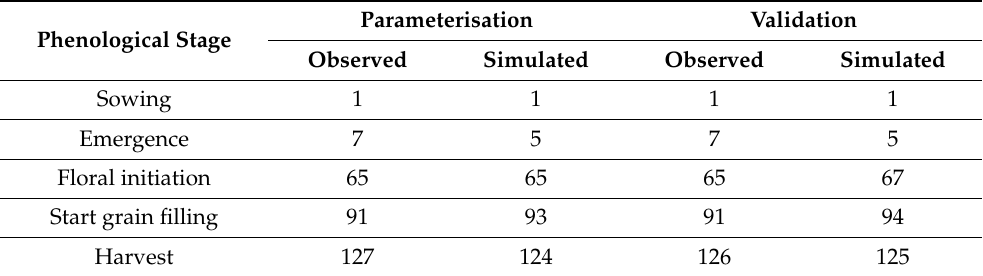
Figure 3. Photographs of the V-notch (90 ◦ ) and irrigation canals used to conduct this study. The observed and simulated phenology for the parameterisation and validation data- sets are shown in Table 2 (parameterisation and validation were conducted using 2018–2019 and 2019–2020 data, respectively). The minimum (mean minus standard deviation) and maximum (mean plus standard deviation) standard deviation ranges for the harvest days, based on three field plots, were 124 and 130 days after sowing for the parameterisation dataset, respectively. The simulated harvest days after sowing for the parameterisation period was within the standard deviation of the observed mean, indicating adequacy of the parameterisation. The minimum (mean minus standard deviation) and maximum (mean plus standard deviation) standard deviation ranges for the harvest days, based on three field plots, were 124 and 128 days after sowing for the validation period, respectively. The simulated harvest days after sowing for the validation period (125 days) was within the standard deviation of the mean. The simulated harvest days after sowing for the validation period was within the standard deviation of the mean, indicating the adequacy of the parameterisation approach. Table 2. Observed and simulated phenology (days after sowing) for the parameterisation (2018–2019) and validation